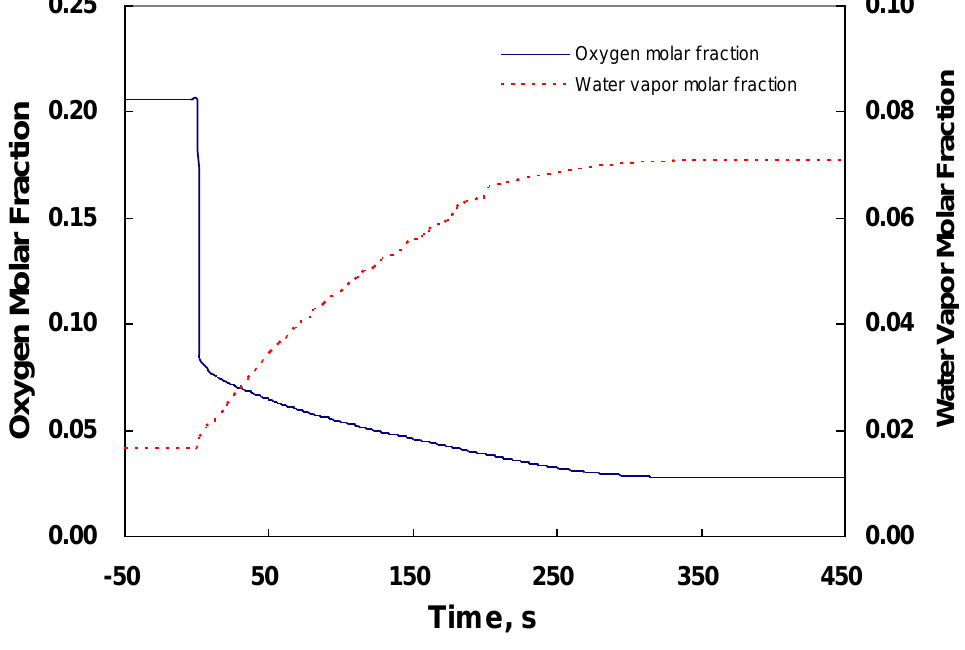
Figure 5. Response of molar fraction of oxygen and water vapor in the middle of the catalyst layer during a step change of potential from 0.9 V to 0.4 V. Solid line represents the oxygen molar fraction and dashed line is the vapor molar